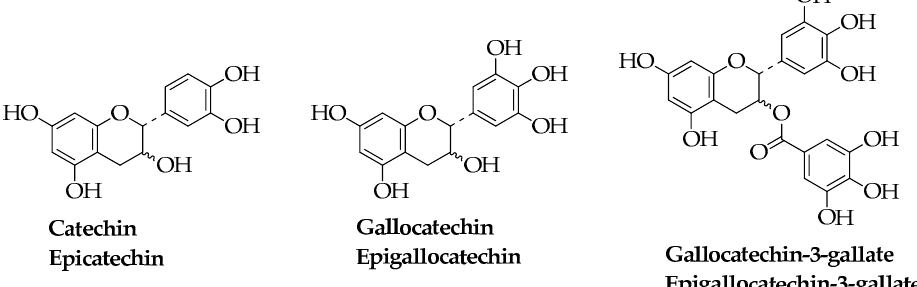
Figure 3. Catechin derivatives.